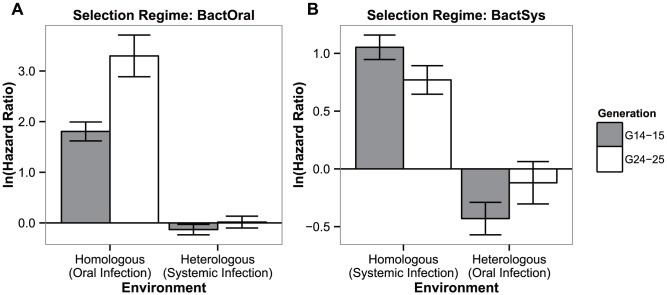
Test of adaptation and its correlated response.Hazard ratios of lines evolving in presence of a pathogen relative to controls at generations 14–15 (grey bars) and 24–25 (white bars) of adaptation, when exposed to the challenge they have evolved with or to the other infection route. (a) Oral infection selection regime (BactOral) and (b) systemic infection evolved flies (BactSyst). All populations spent one generation in a common environment before being tested. Vertical bars correspond to the standard error of the estimated ratio between the two selection regimes.